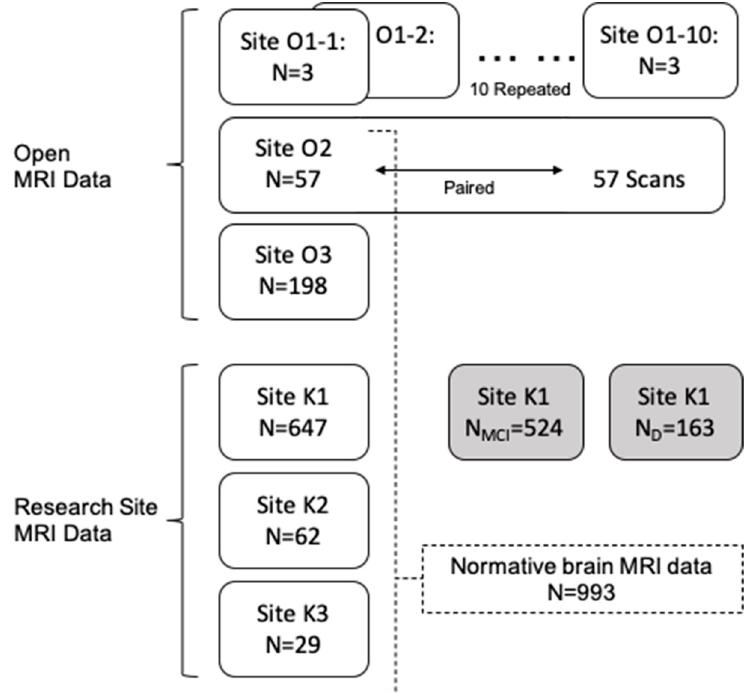
Figure 1. Data sets used in this study are shown by their source and their usage. MRI data from two sources are used: Open MRI data (Site O N ) and our research site data (Site K N ). Site O1, consisting of three subjects scanned at 10 (O1-1~O1-10) different sites, was used to investigate multicenter reliability. Site O2 data includes 57 paired scans for the same subjects from the same scanner and used (1) to measure repeated measure consistency and (2) to construct normative data. Sites O2, O3, K1, K2, and K3 are one-time scans from cognitive normal participants. Site K1 additionally includes data for MCI and dementia, compared with our multisite normative data. MCI, mild cognitive impairment; D, dementia.